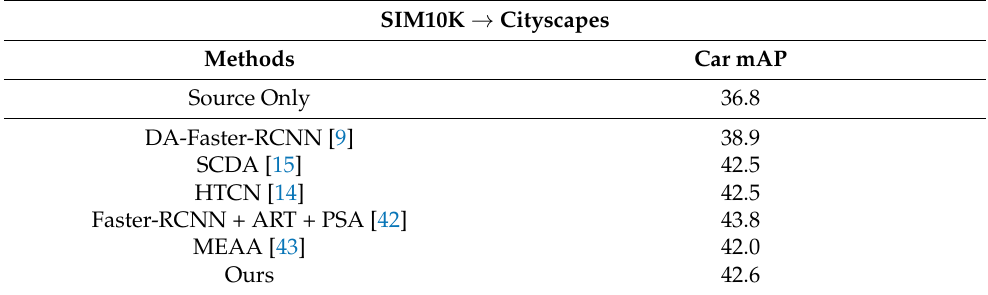
Table 3. Synthetic-to-reality adaptation: results on adaptation from SIM10K to